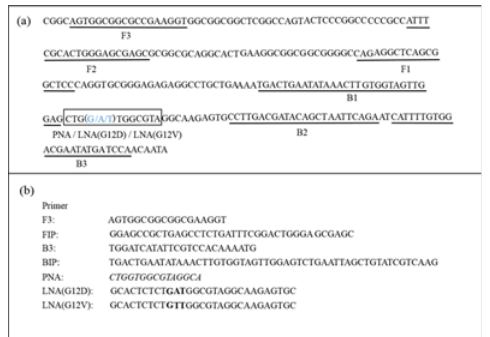
Fig 2. Set of PNA-LNA mediated LAMP primers used. (a) The figure shows the DNA sequence of codon 12 of the KRAS gene. The wild and mutated nucleotides in KRAS codon 12 are shown in bold blue type (G for the wild type, A for G12D and T for G12V.). (b) The figure indicates the design of the set of LAMP primers and the PNA probe. The italic faces indicate modification site of PNA and the bold faces indicate modification site of